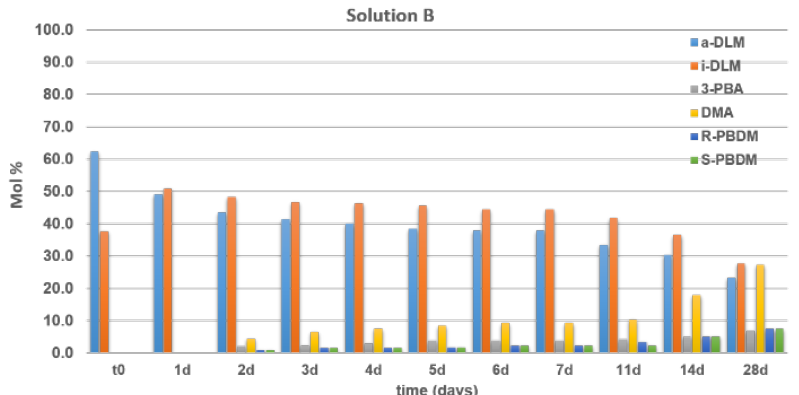
Figure 3. Degradation of a -DLM over time at room temperature in solution B. DLM: deltamethrin; 3-PBA: 3-phenoxybenzaldehyde; DMA: cis -decamethrinic acid; PBDM: α -3-phenoxybenzoyl-deltamethrin.